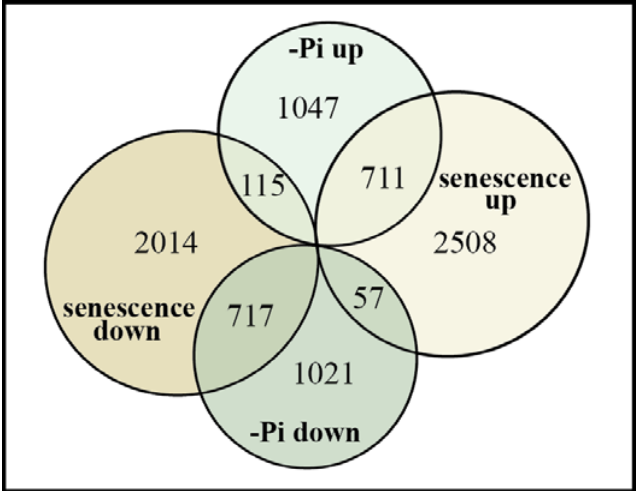
Figure 1. Transcript profiles of Pi-deficient shoots and senescing leaves share overlapping gene expression changes in the model plant Arabidopsis thaliana . Numbers of down-regulated or up-regulated genes during leaf senescence [21] or during Pi-deprivation [37] are indicated. Figure modified from